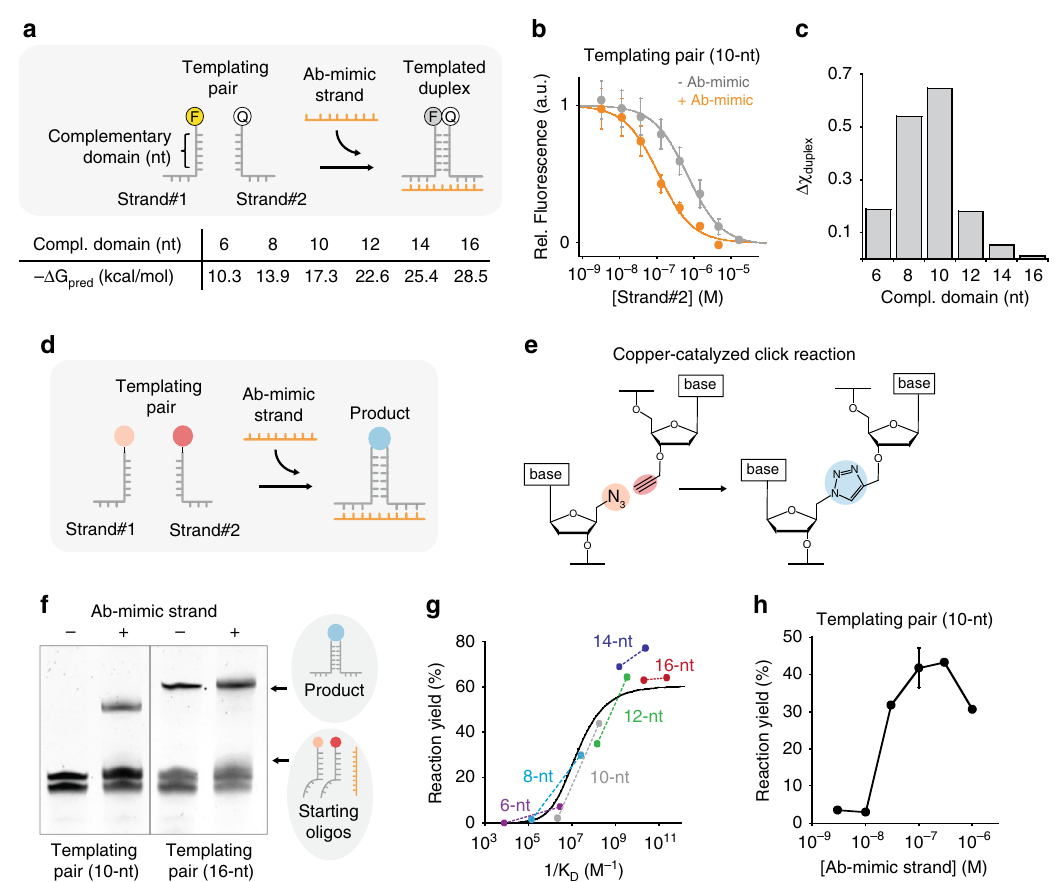
Fig. 2 Reaction templated by an antibody-mimic (Ab-mimic) DNA strand. a We designed a DNA oligonucleotide that mimics the co-localization effect induced by the bivalent binding of an IgG antibody to a templating pair (see Fig. 1). Optically modi fi ed oligonucleotides were initially tested to study the effect of the Ab-mimic on the duplex formation. Templating pairs with complementary domains of different lengths were used. Shown are the predicted free energy values of duplex formation between the templating pair. b Binding curves between Strand#1 and Strand#2 (the complementary domain of 10- nt) in the absence and presence of the Ab-mimic strand. c Difference in duplex molar fraction for different lengths of the complementary domain in the presence and absence of Ab-mimic strand calculated for an equimolar concentration of templating pairs and Ab-mimic strand of 100 nM. Data from Supplementary Table 4. d Scheme depicting the reaction co-templated by the Ab-mimic strand. e Azide and alkyne groups leading to copper-catalyzed click (CuAAC) reaction were used as reactive groups. f Denaturing PAGE of CuAAC reaction in the presence and absence of the Ab-mimic for templating pairs with complementary domains of 10 and 16 nt. g Plot of reaction yield vs. the inverse of dissociation constant. Each pair of connected dots is relative to the indicated length of complementary domains. For each pair, the dot on the left corresponds to the experimental yield in the absence of the Ab-mimic strand vs. 1/ K D_no_template , whereas that on the right corresponds to the experimental yield in the presence of the Ab-mimic strand vs. 1/ K D_Ab_mimic . The solid curve is the theoretical yield obtained by fi tting the experimental points to the kinetic model of the system. h Reaction yield determined by densitometric analysis of PAGE bands at different concentrations of Ab-mimic strand (10-nt templating pair). The fl uorescence experiments (panel b ) were performed at 37 °C in 25 mM HEPES buffer pH 7.2, 0.1 M NaCl at a fi xed concentration of Strand#1 (10 nM) and increasing concentrations of Strand#2 in the absence and presence (i.e., 100 nM) of Ab-mimic strand. Templated CuAAC reactions (panel f ) were performed at 37 °C for 2 h at equimolar concentrations (i.e., 100 nM) of Strand#1, Strand#2 and Ab-mimic (when indicated) in presence of Cu(l) catalyst (details of catalyst composition described in methods part) in 25 mM HEPES buffer pH 7.2, 0.1 M NaCl. The experimental values represent averages of three separate measurements and the error bars re fl ect the standard deviations. Source data are provided as a Source Data fi